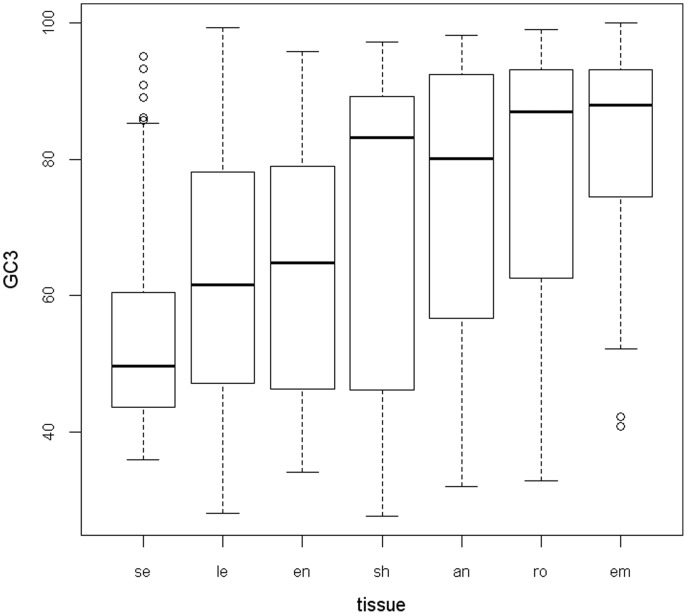
Illustration of GC3 content variation for genes selectively expressed in different tissues.For each tissue, the distribution of GC3 content is represented by a boxplot, where the lower, middle, and top horizontal lines of the boxes represent the 25%, 50%, and 75% quantiles, respectively. Initials of tissue names are indicated: se, seed; le, leaf; en, endosperm; sh, shoot; an, anther; ro, root; em, embryo.